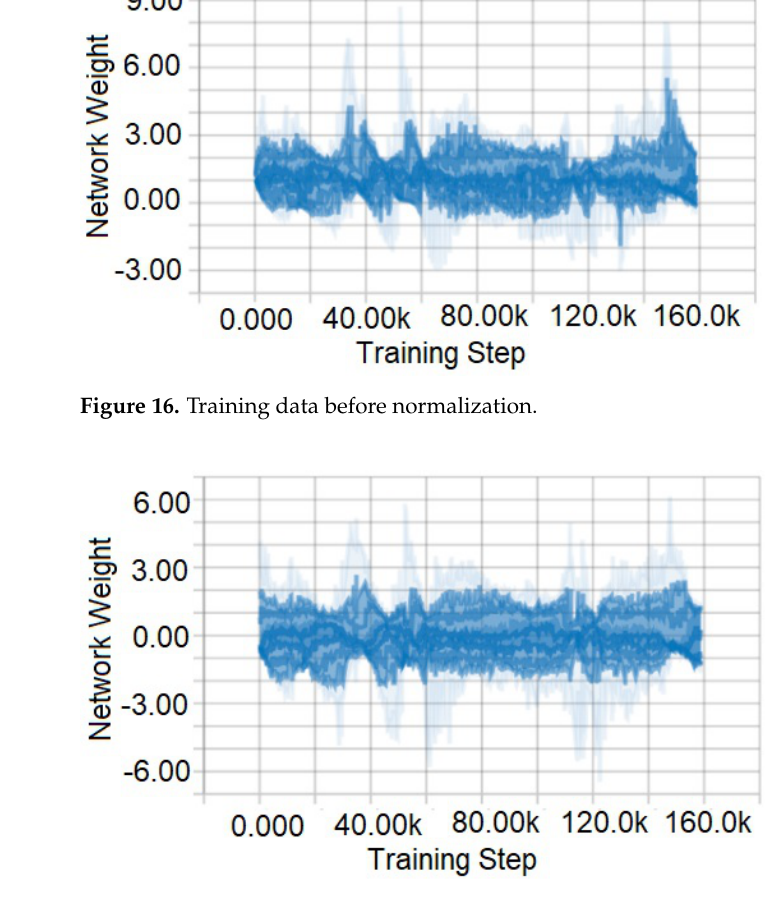
Figure 17. Training data after normalization.